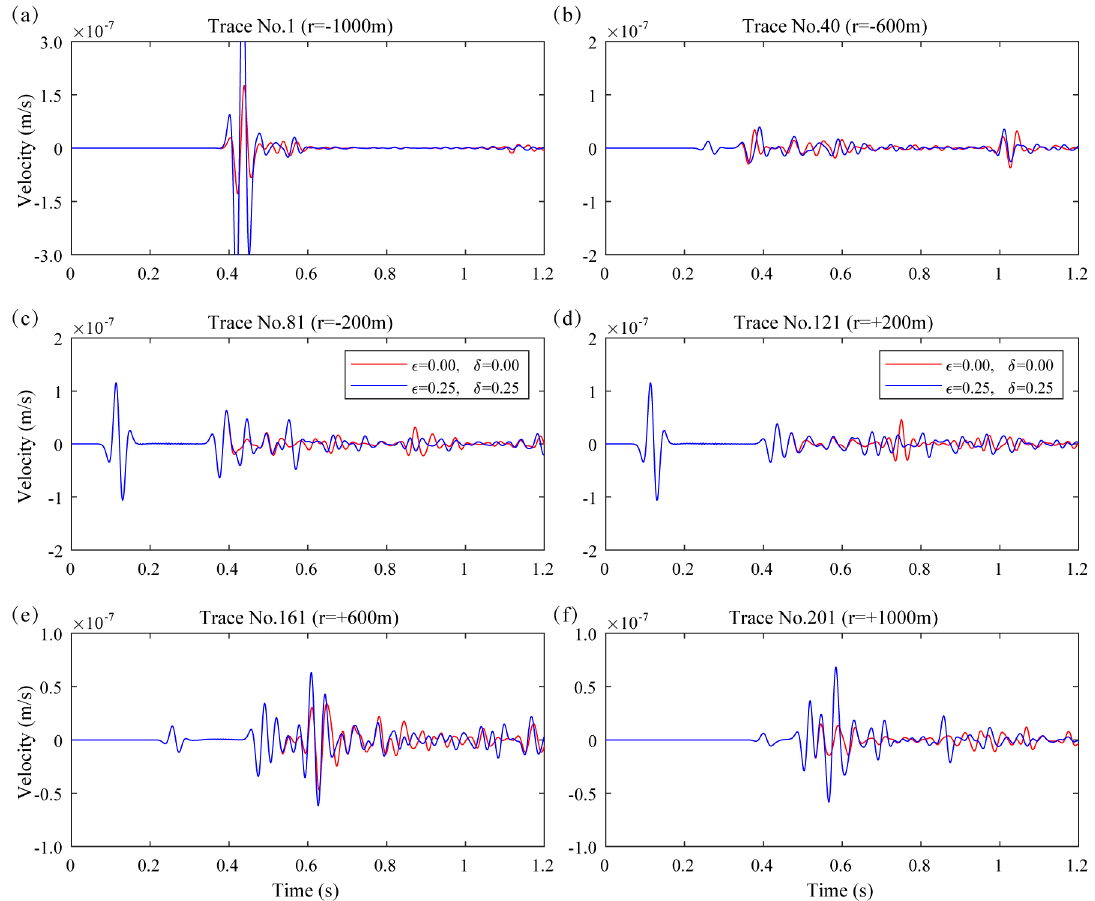
Figure 13. Comparison of Z-component waveforms from model M ED and M 0 (with / without anisotropy, JY depression model). ( a )–( f ) are waveform records of geophones No.1 / 41 / 81 / 121 / 161 / 201 (with epicentral distance − 1000 / − 600 / − 200 /+ 200 /+ 600 /+ 1000 m, the sign indicates that the detectors are located on two sides of the source, positive along X-axis direction). Red indicates synthetic waveforms from model M 0 (without anisotropy); blue indicates seismic waveforms from model M ED (with shale anisotropy).